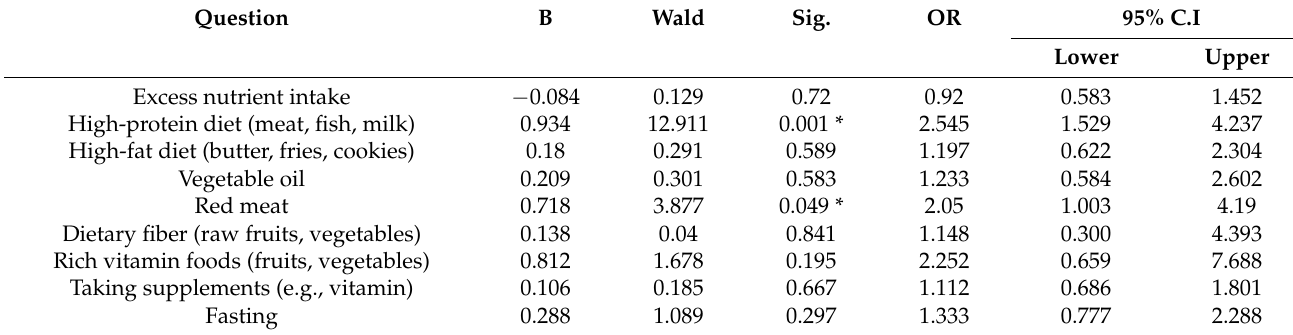
Table 6. Nutritional status as predictors of psychosocial skills of offspring (n =